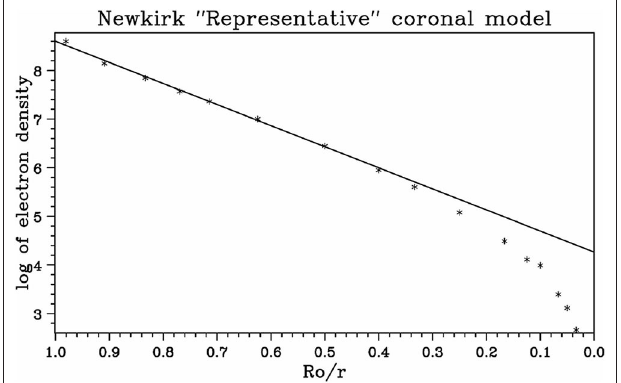
FIGURE 3 | Equatorial “representative” coronal density at minimum, after Table 1 of Newkirk (1967), as a function of the inverse distance from the center of the Sun, up to 30 R . The solid line represents a hydrostatic fit up to r ⊙